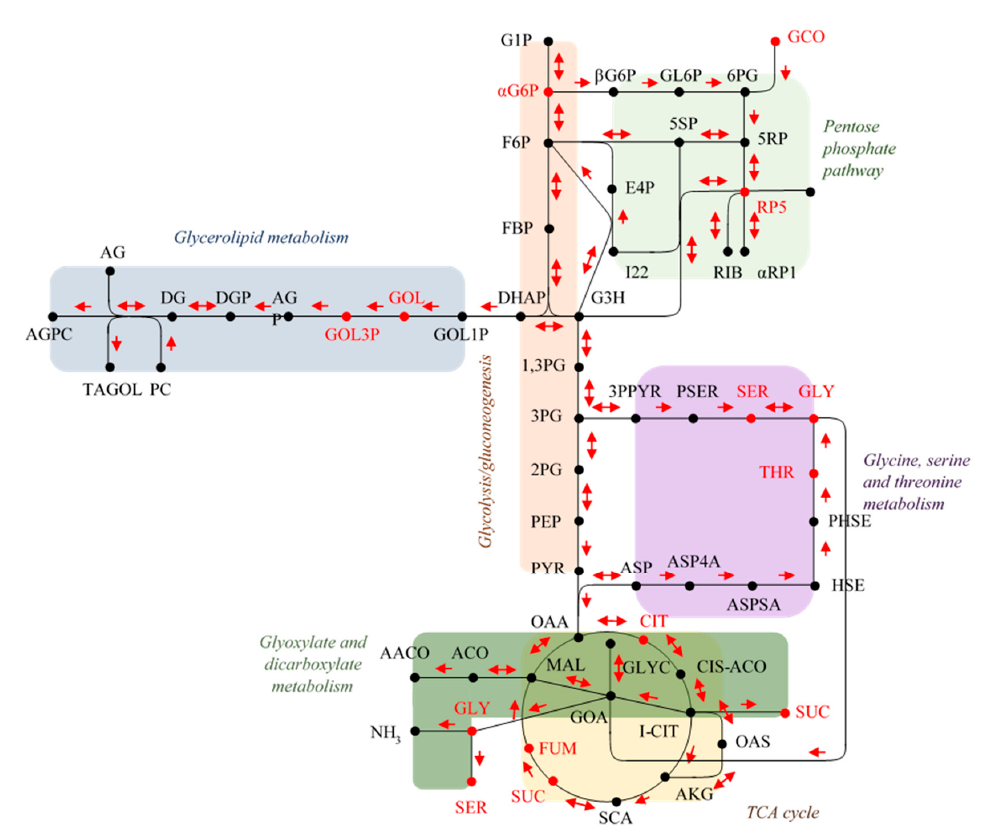
Figure 4. Metabolomic map of flor yeast gluconic acid consumption. Metabolites quantified are represented in red. SGD YeastPathways and KEGG PATHWAY Database—GenomeNet have been used for pathways and gPDB-CCD, SGD, Sigma Aldrich and CHEBI abbreviations have been used for metabolites labelling: 1,3PG: 3-Phospho- D -glyceroyl phos- phate; 1,5RP: 5-phospho-alpha- D -ribose 1-diphosphate; 2PG: 2-phosphoglycerate; 3PG: 3-phosphoglycerate; 3PPYR: